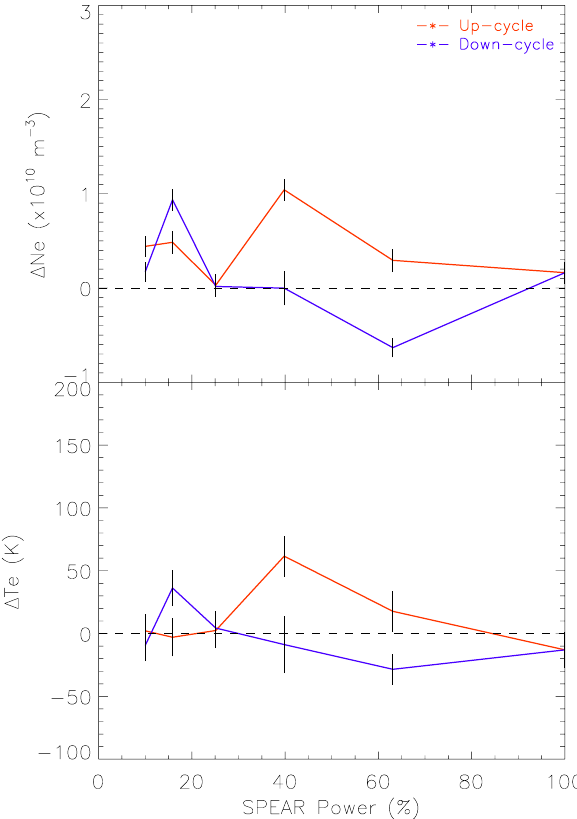
Fig. 8. Electron density (upper panel) and electron temperature (lower panel) measurements of the local ionosphere made using the ESR during the SPEAR power stepping experiment on 10 October 2006. Here the data have been averaged over all seven power cy- cles and are presented for the heater interaction altitude of 158km. The vertical black lines represent the errors bars associated with the